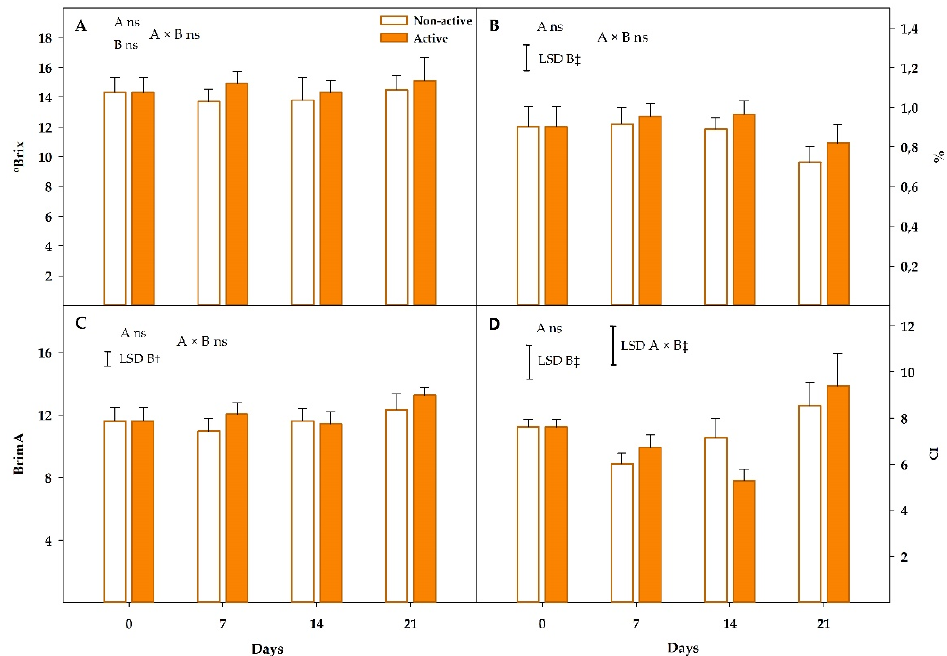
Figure 4. Soluble solids content ( A ), titratable acidity ( B ), BrimA maturity index ( C ) and colour index ( D ) of mandarins packaged within non-active and active packages up to 21 days at 8 °C (n = 3 ± SD). Least significant differences (LSD) are represented with bars. The uppercase letters A and B denote package type and storage time, respectively. ns, not significant ( p > 0.05). † and ‡ signi fi cance for p ≤ 0.01 and 0.001, respectively.